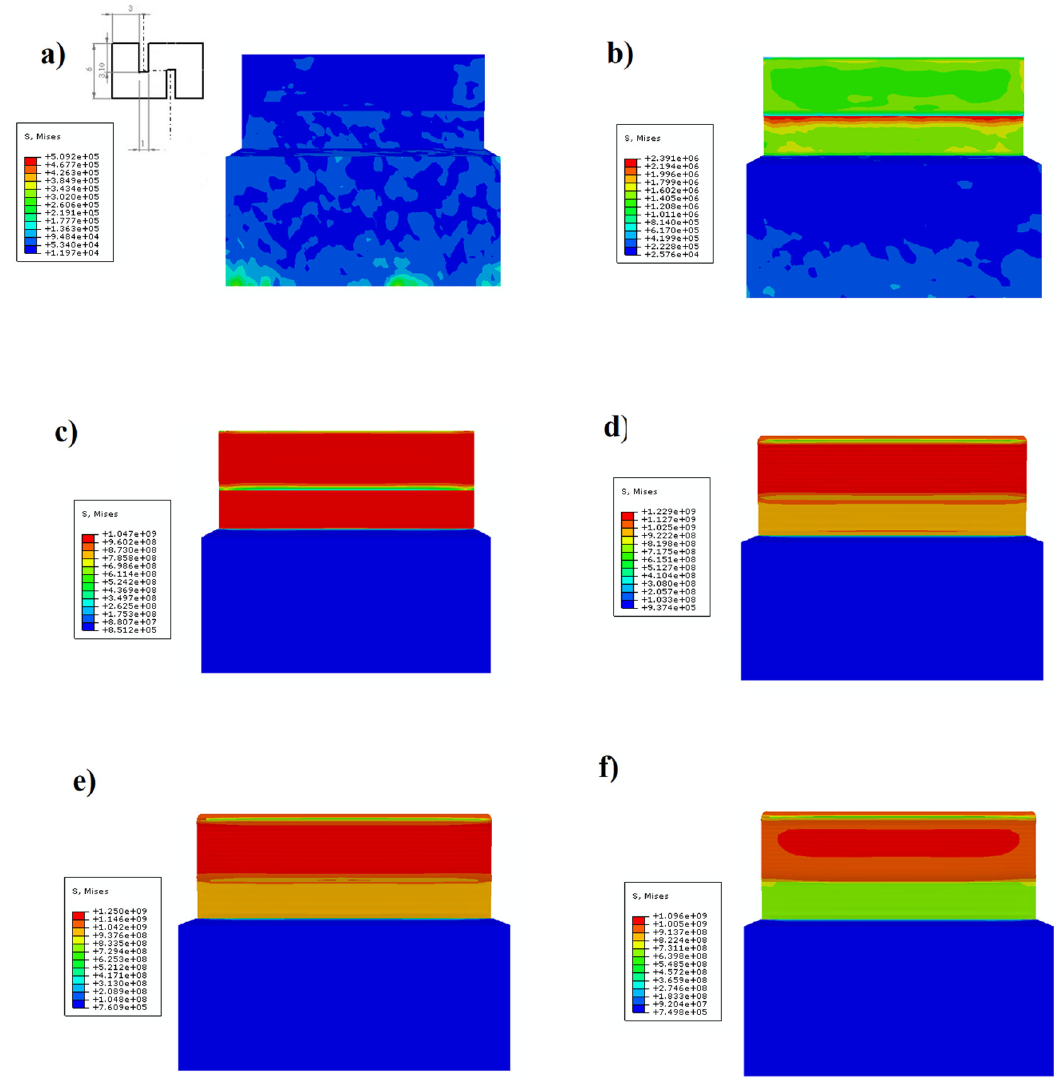
Figure 17. Contour of the equivalent stress on the shear gauge of NSSS ( a ) 0 μ s, ( b ) 6.6 μ s, ( c ) 30 μ s, ( d ) 60 μ s, ( e ) 90 μ s, and ( f ) 110 μ s.